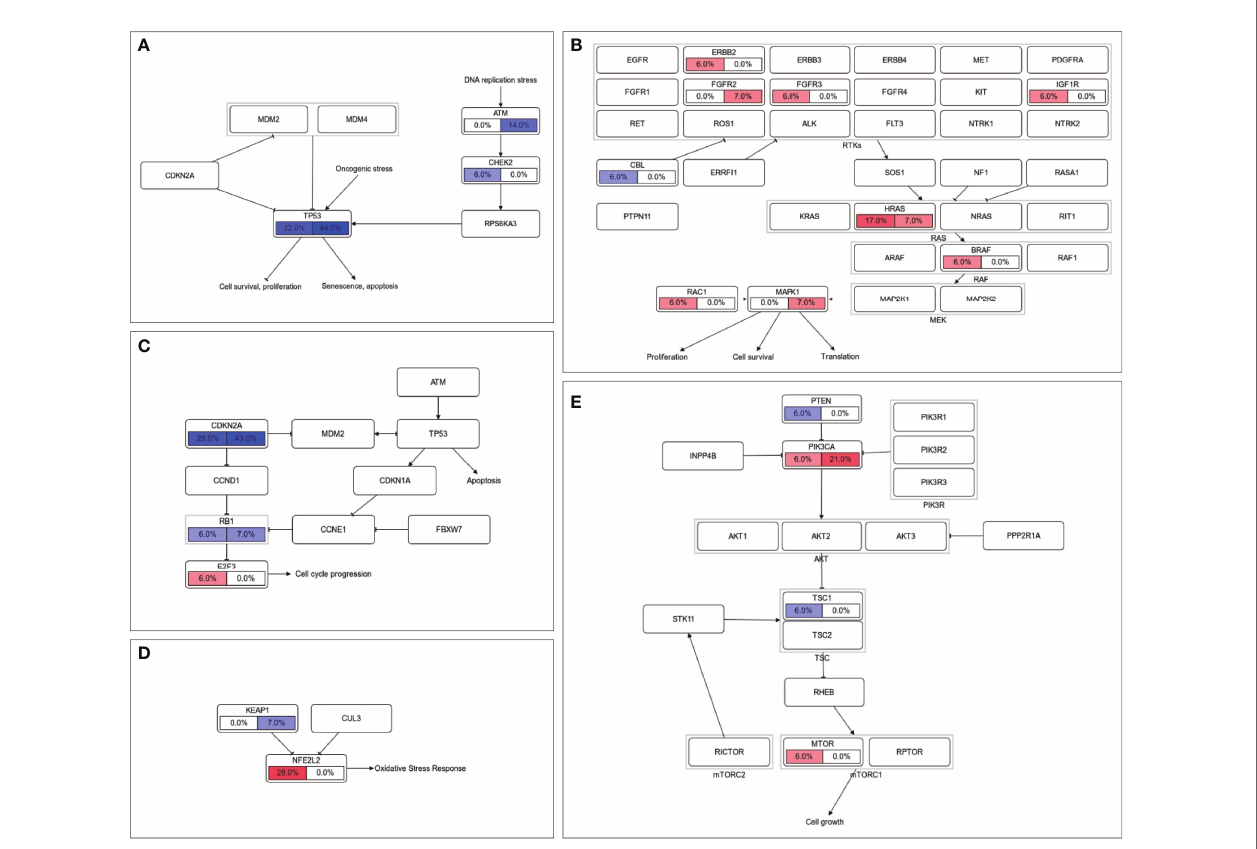
FIGURE 4 | Comparison of somatic alterations between LNM subgroups in signaling pathway level. Mutation frequencies of genes in (A) TP53 pathway, (B) RTK- RAS pathway, (C) cell cycle pathway, (D) NRF2 pathway and (E) PI3K pathway were labeled with LNM negative on the left and LNM positive on the right. Oncogenes were fi lled with red color and tumor suppressor genes were fi lled with